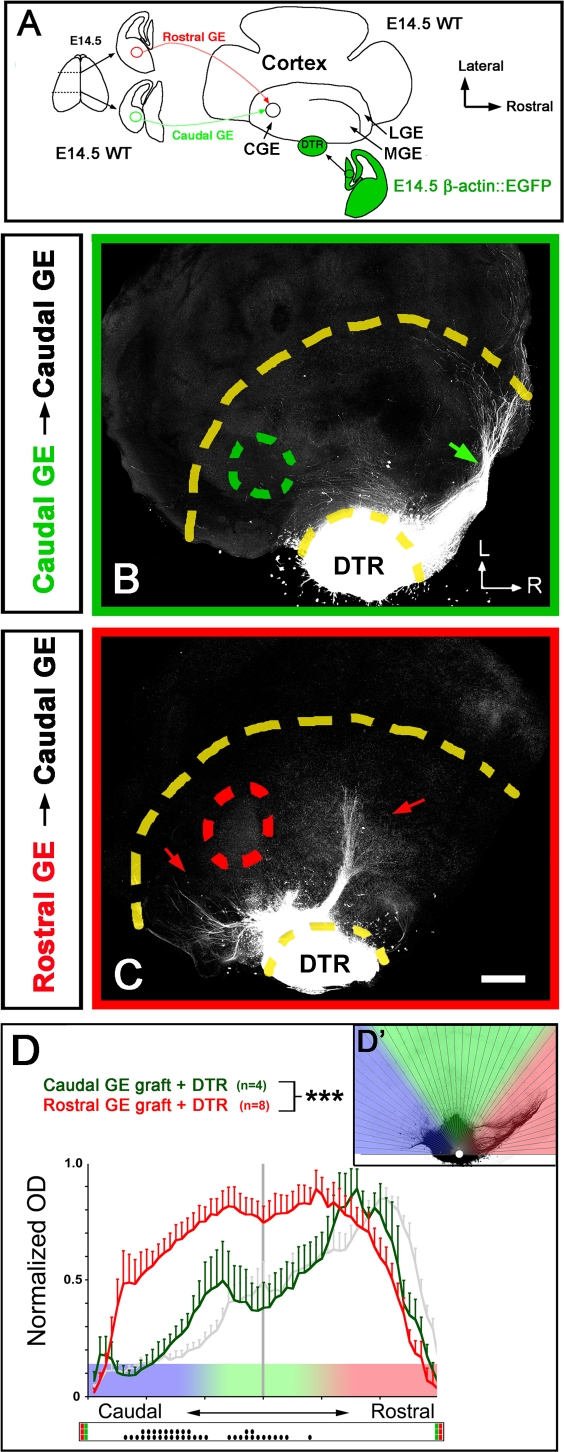
The Rostral Part of the Ganglionic Eminence Contains a Chemoattractant for Rostral Thalamic Axons(A) Rostral (red) or caudal (green) explants isolated from the mantle region of the ganglionic eminence (VTel) were isolated from 250-μm–thick vibratome sections and grafted into the caudal part of the VTel of a recipient E14.5 whole-mount telencephalic vesicle as described previously (Seibt et al., 2003 [10]). The rostral part of the DTh (DTR) isolated from coronal slices of an isochronic β-actin::EGFP-expressing mouse embryo (see Figure S11 for details on explant isolation) is cocultured with the whole-mount telencephalon for 4 d in vitro (div; see Materials and Methods for details). CGE, caudal ganglionic eminence; GE, ganglionic eminence; LGE, lateral ganglionic eminence; MGE, medial ganglionic eminence; WT, wild type.(B) Homotopic grafting (caudal VTel into caudal VTel) results in a normal outgrowth of rostral thalamic axons into the rostral domain of the VTel (arrow). L, lateral; R, rostral.(C) In contrast, heterotopic grafting (rostral VTel into the caudal VTel) results in a pronounced change in the topography of DTR axon projections, which invade more-caudal territories (red arrows) than in control grafts (see [B]).(D) Quantification of the topography of rostral thalamic axon outgrowth in the VTel presenting homotopic (green) or heterotopic (red) VTel graft into the caudal VTel. The gray curve illustrates the topography of DTR axons projection in control, nongrafted, experiments shown in Figure 5D. Each histogram represents the average normalized optical density (OD) from the EGFP signal measured in 60 radial bins centered on the thalamic explant as shown in (D′). Triple asterisks (***) indicate p < 0.001, ANOVA one-way test (overall effect: bins versus experimental conditions). The raster-like dot plot presented under the histograms represents the significance of individual bin comparisons between the two experimental conditions according to a Fisher Protected Least Significant Difference (PLSD) post hoc test (a single dot [•] indicates p < 0.05; and double dots [••] indicate p < 0.01).Scale bars in (B and C) represent 250 μm.